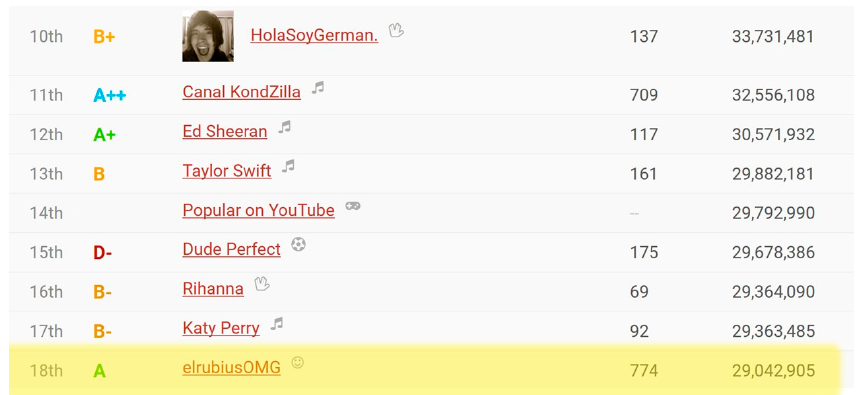
Figure 5. Youtuber, elRubius, in 18th position in terms of subscribers and 92nd in terms of video views worldwide. 5 May 2018.